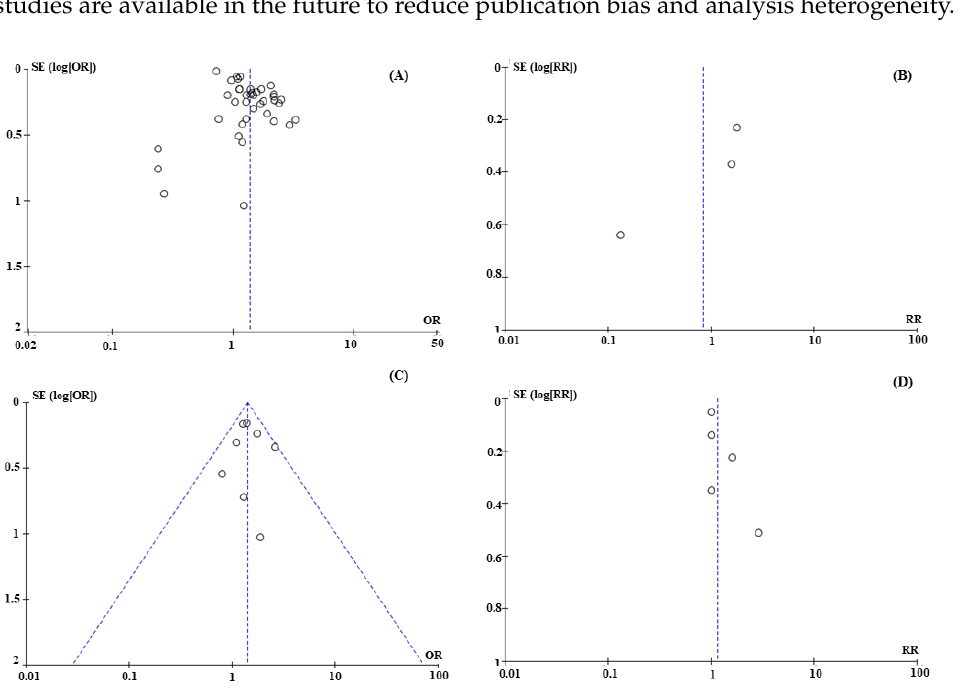
Figure 4. Publication bias of case–control studies related to radon-associated lung cancer and childhood leukemia. ( A ) Lung cancer-based studies with estimated OR values; ( B ) Lung cancer-based studies with estimated RR values; ( C ) Childhood leukemia-based studies with estimated OR values; ( D ) Childhood leukemia-based studies with estimated RR values.